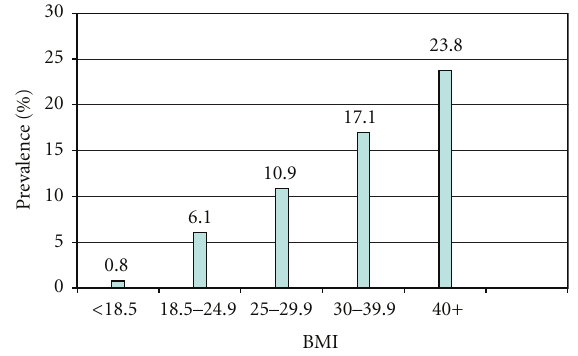
Figure 2: Prevalence in percentage of hypertension by BMI in Saudi Arabia, 2005.